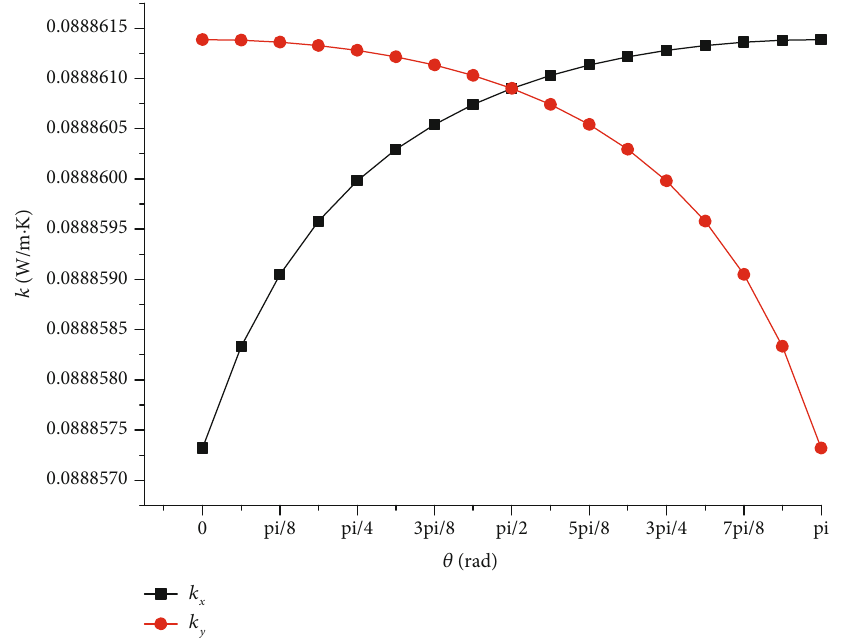
Figure 22: The relationship between the equivalent thermal conductivity in the x and y directions and the angle of fi